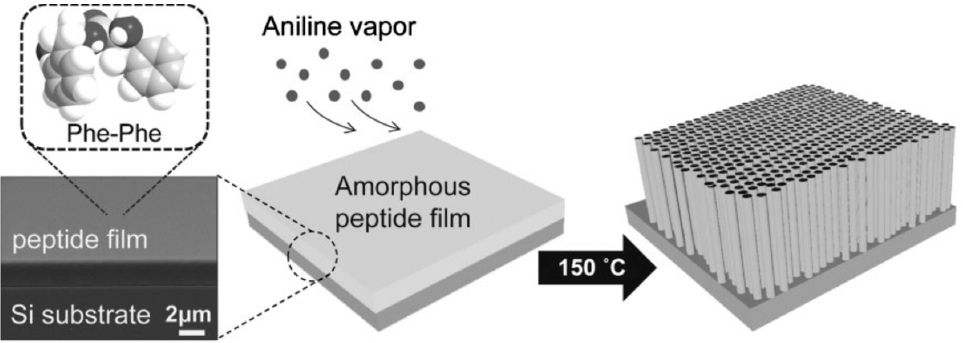
Figure 2. Peptidic nanowires vertically grown under aniline vapors. With permission from Reference [27]. At 50 °C, no change in the film was observed in the absence of aniline, whereas thick nanorods were formed in the presence of aniline. At temperatures of 100 and 150 °C, and with or without aniline vapour, one-dimensional nanostructures were formed, but with different shapes: while the high-temperature aniline vapor aging resulted in the formation of uniform and well-aligned peptide nanowires, dry air aging without aniline at the high temperatures promoted the growth of highly flexible nanofibrils with an irregular shape,